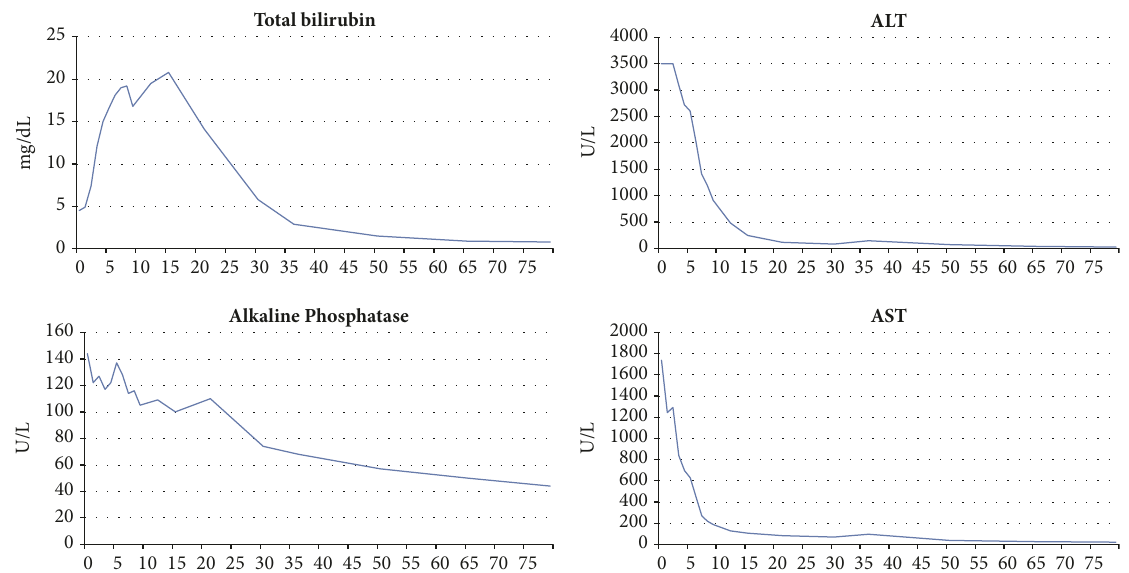
Figure 1: Time-course of liver function studies. The x-axis spans from Day 0 (day of admission and cessation of crizotinib therapy) to Day 79.